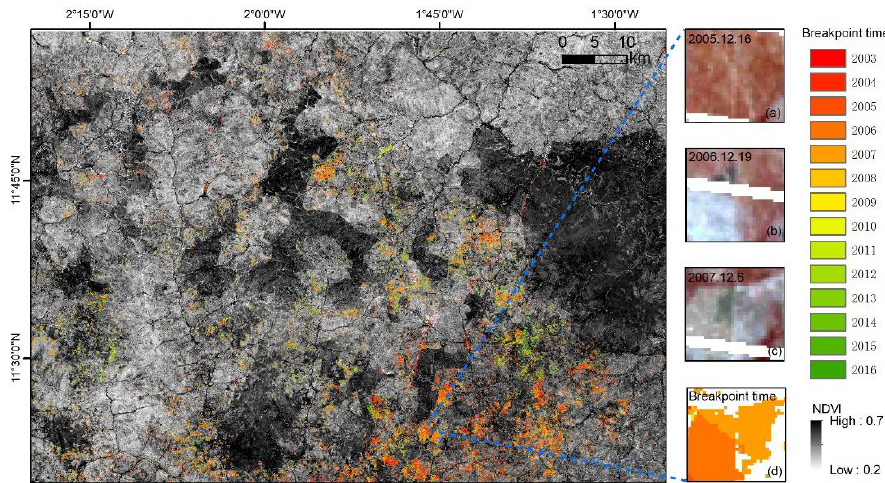
Figure 2. The disturbance map with breakpoint time (left panel), and an example of land cover change were identified ( a , b , c , d ) in the 2005–2007 period.